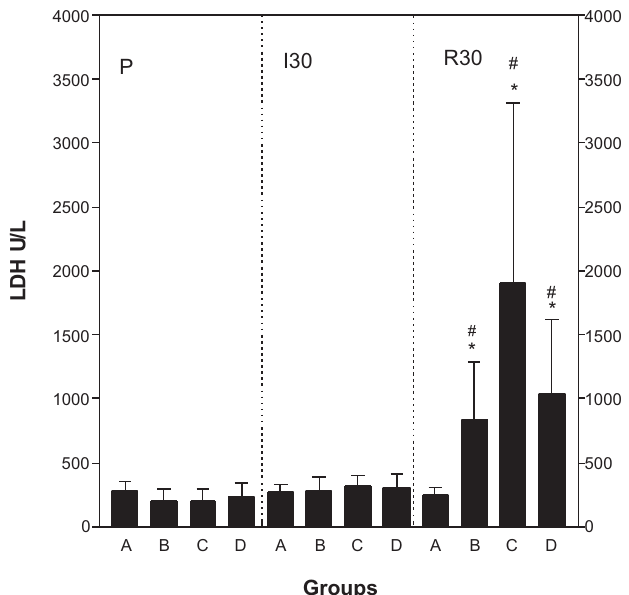
FIGURE 3 – Serum lactate dehydrogenase (LDH) level in animals during the surgical